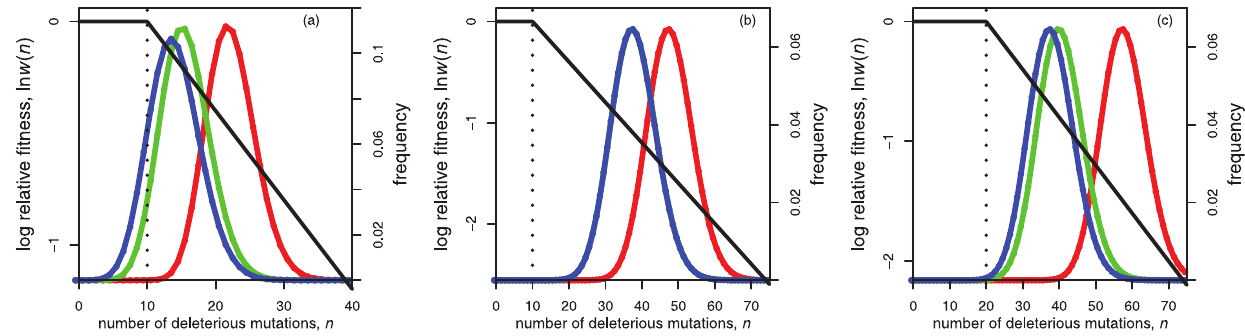
Figure 2. Fitness landscapes and equilibrium frequency distributions. With the fitness landscapes shown, the first few mutations have a negligible effect on fitness until they reach a threshold. After that, each mutation decreases fitness by around 5%. Parameters for the three panels were: (a) U ~ 0 : 5 , k ~ 10 ; (b) U ~ 1 : 5 , k ~ 10 ; (c) U ~ 1 : 5 , k ~ 20 . In all cases, a 1 ~ 0 , a 2 ~ 0 : 05 , b ~ 0 . All other conventions (axes, colour-coding etc.) as Figure 1. Note that in panel (b), sexual populations with and without recombination attain the same equilibrium (such that the green curve is hidden); while in panel (c), the red (asexual) curve would be unlikely to apply to any population of plausible finite size, as drift would be likely to dominate the